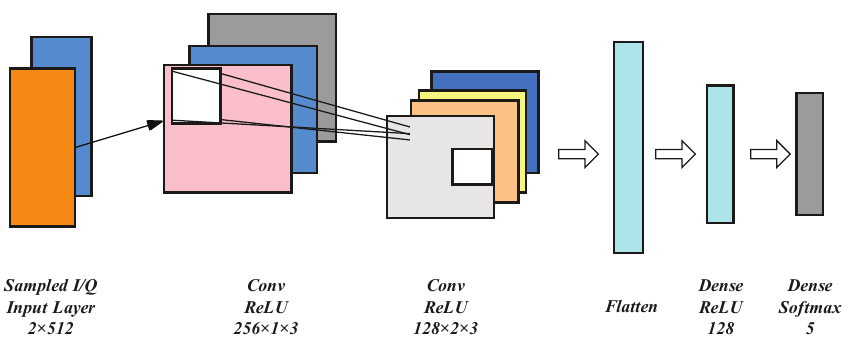
Figure 9. The architecture of the CNN network for classifying multiple modulation types and multiple emitters.